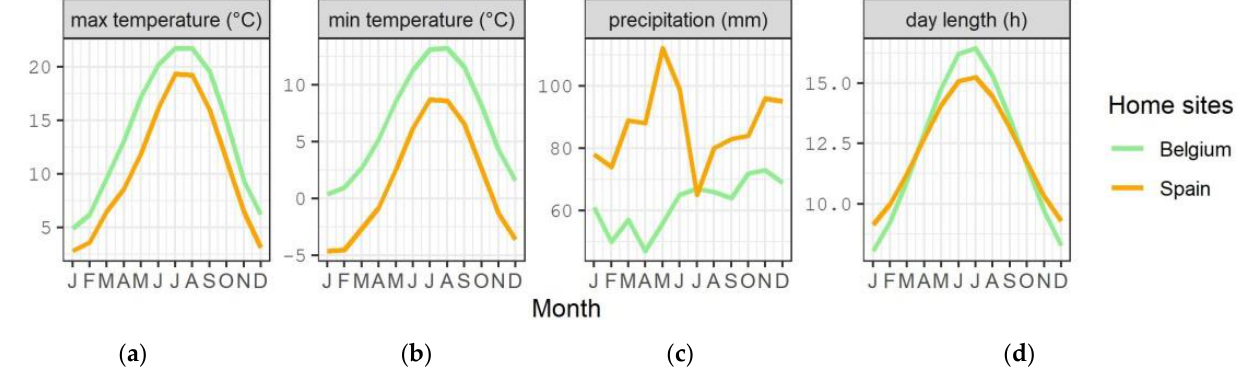
Figure 1. Climate and day length at the origin of the provenances of Corylus avellana , Corylus maxima and the intermediate forms, and Cornus sanguinea . ( a ) Mean monthly maximum temperature; ( b ) mean monthly minimum temperature; ( c ) mean monthly precipitation; ( d ) day length.